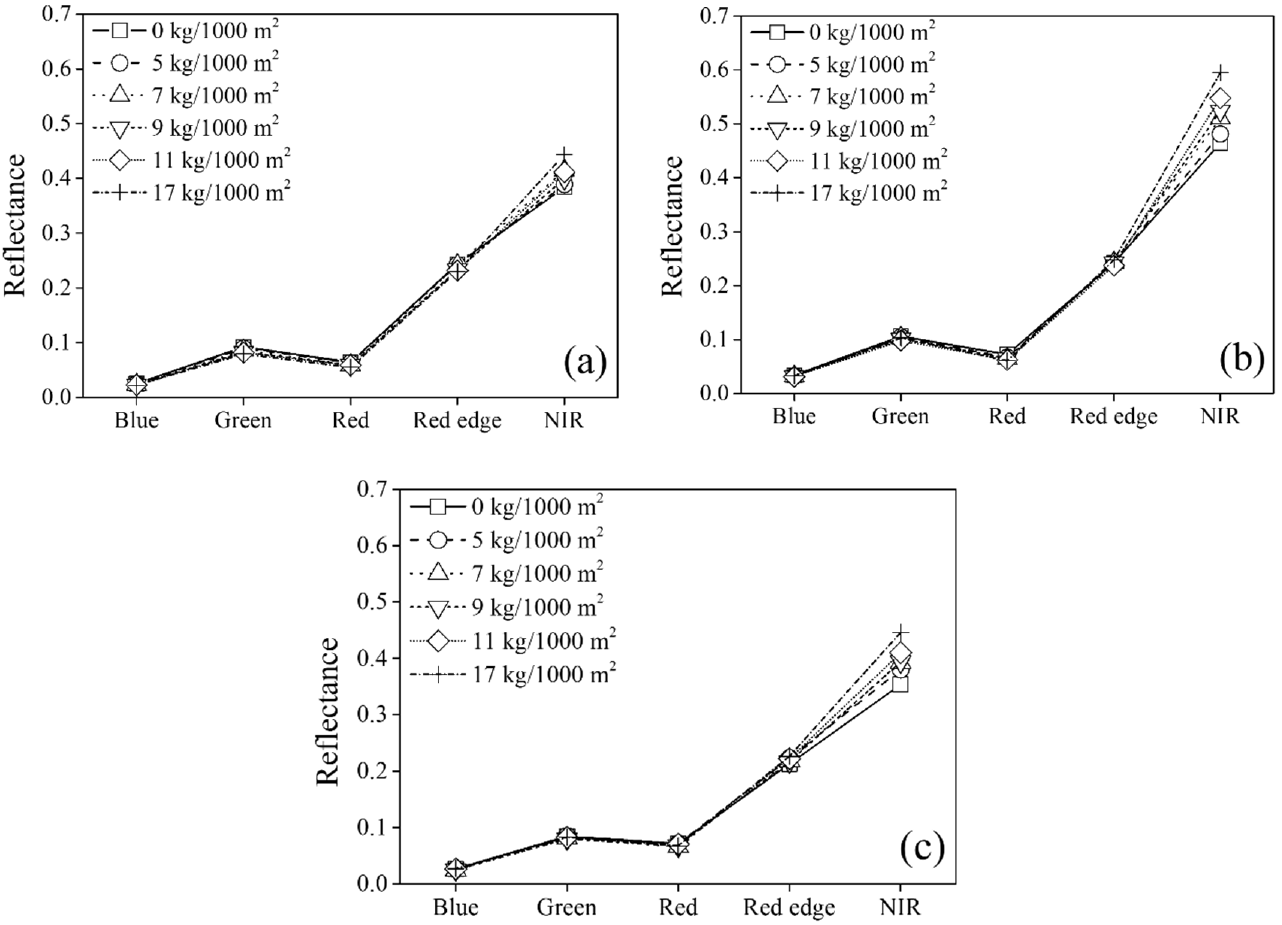
Figure 3. Average reflectance for each spectral band depending on the nitrogen fertilization treatment: ( a ) 2018, ( b ) 2019, and ( c ) 2020.